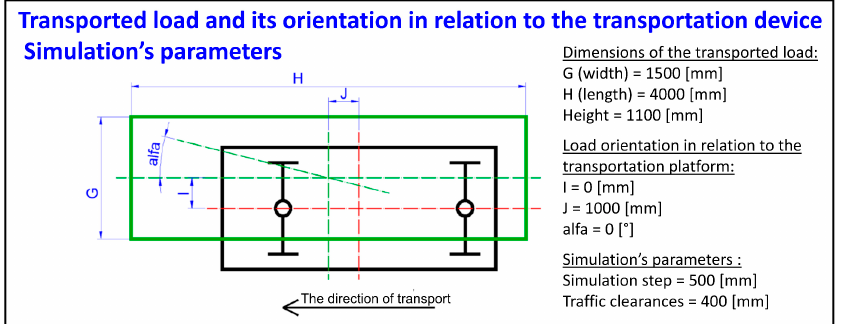
Figure 12. Input data for development of the simulation model in AutoCAD environment—trans- portation device.